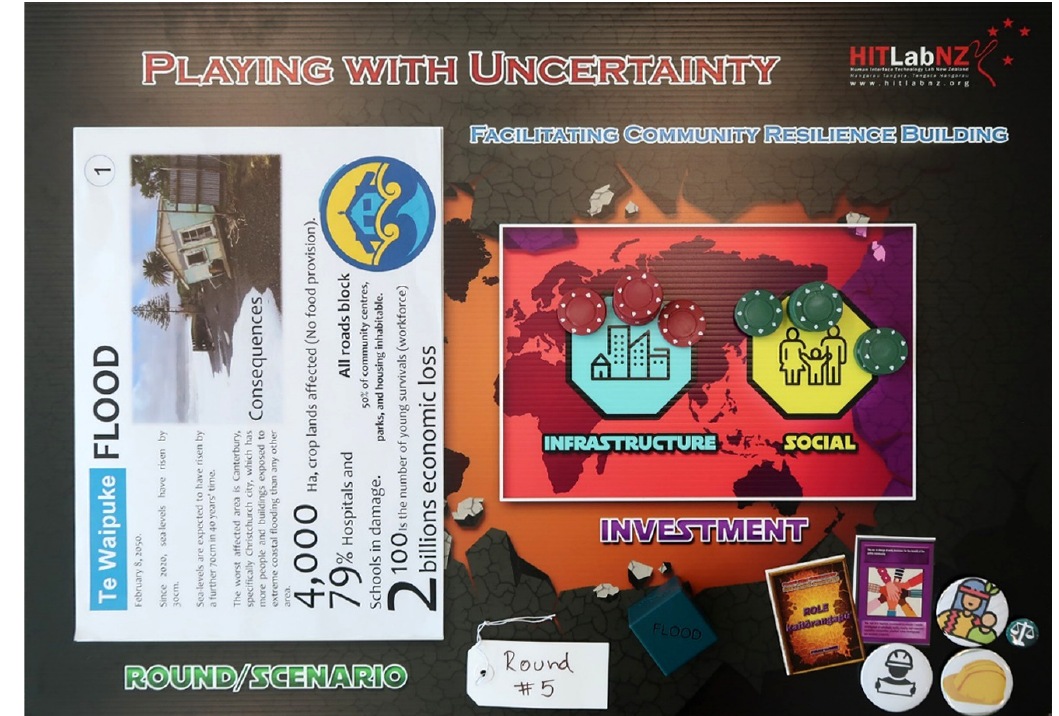
Figure 3. Prototype of table board printed containing all physical elements from the game interacting: Rounds, scenarios, coins, variables, dice, and role‐play cards.